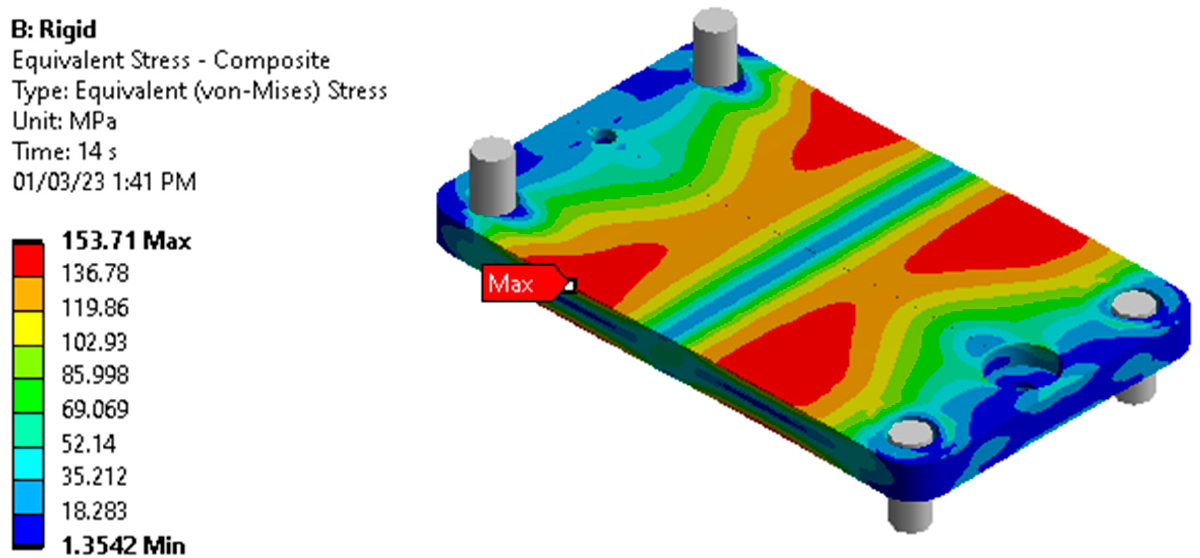
Figure 7. FEA result: displacement of the elastic element under axial load. The displacement has been calculated at the location of the magnet.